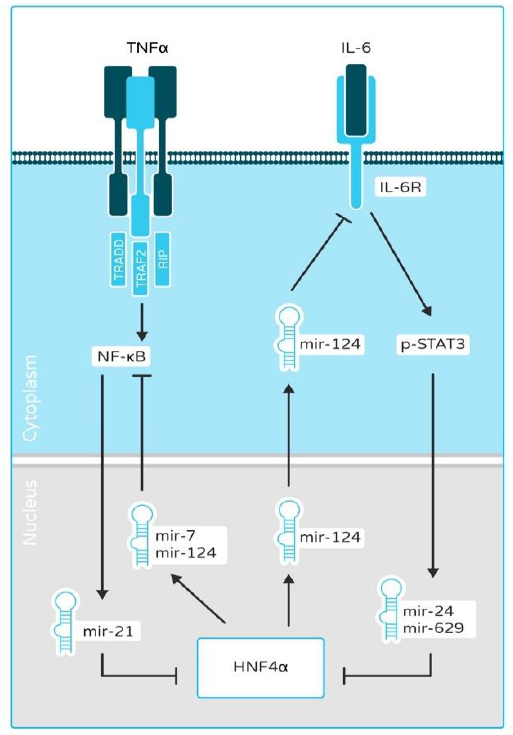
Figure 1. Role of aberrant HNF4 α -inflammatory signaling in cancer. A regulatory pathway involving microRNAs and HNF4 α links inflammatory responses (TNF α , IL-6) to hepatocyte transformation and epithelial-mesenchymal transition (EMT). After induction by stimuli, NF- κ B and IL-6 inhibit the expression of HNF4 α by inducing the expression of miR-21, and miR-24, miR-629, respectively. High HNF4 α expression inhibits the NF- κ B and IL-6 pathways by upregulating the expression of miR-7, miR-124 microRNAs. Aberrant HNF4 α -related NF- κ B, STAT3 and IL-6 signaling pathway is involved in tumorigenesis and the EMT process.